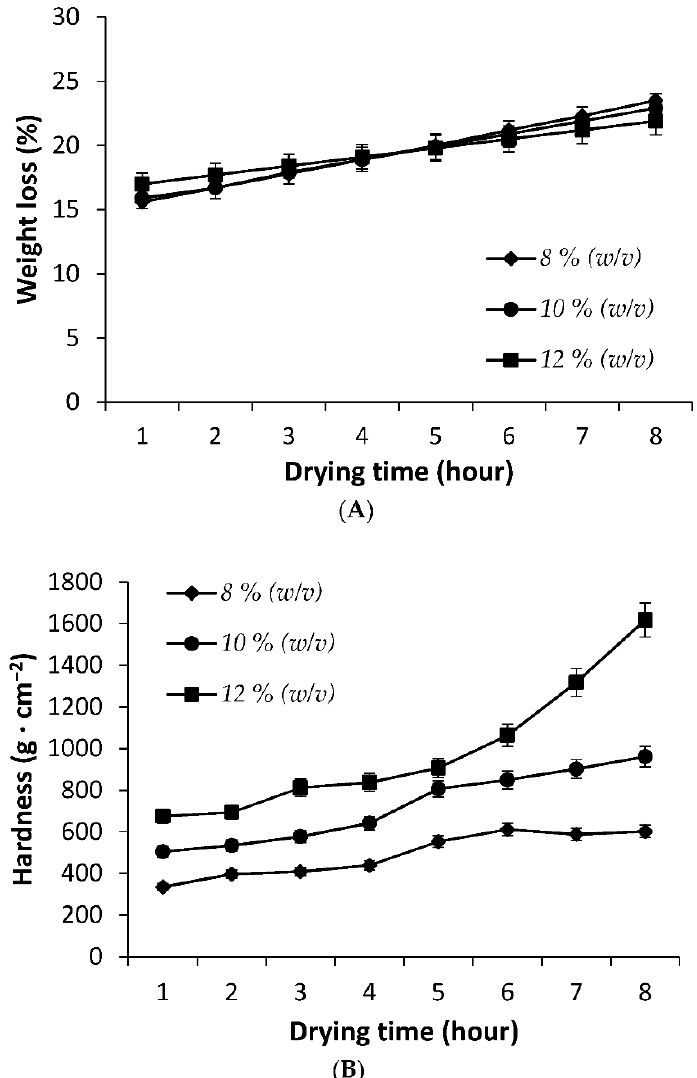
Figure 2. Effects of agarose concentration and drying time on the weight loss ( A ) and hardness ( B ) of the agarose block encapsulating the protocorm. Table 1. Effect of agarose concentrations on the success rate of tTCL sections at 100 µ